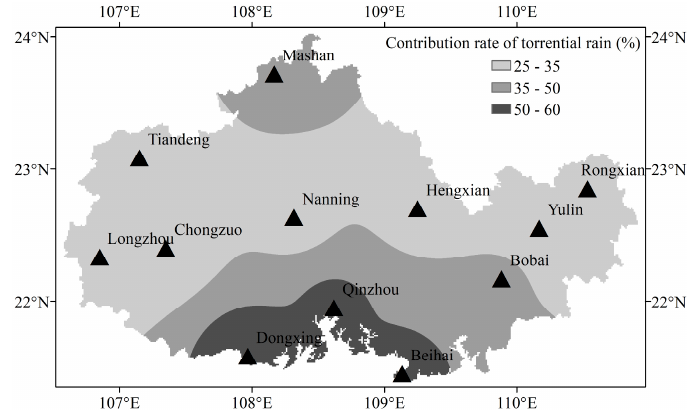
Figure 7. Spatial distribution pattern of contribution rates of torrential rain in the Beibu Gulf.